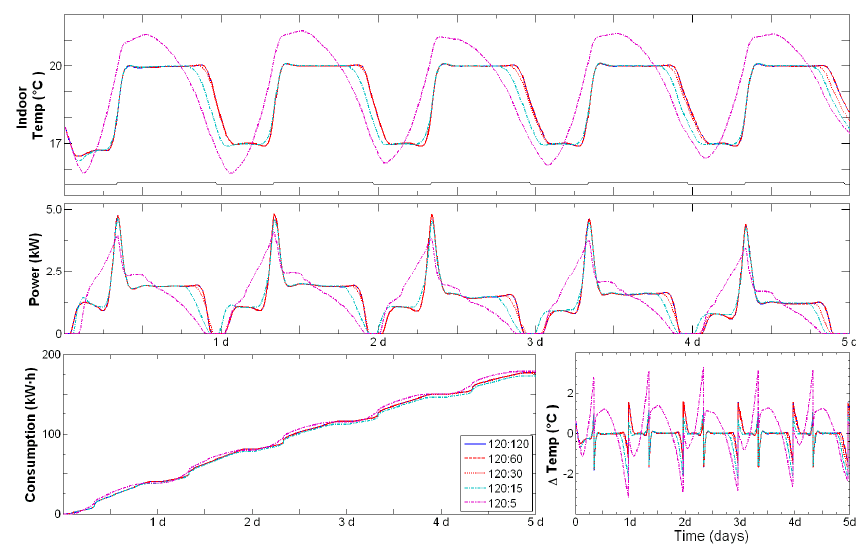
Figure 8. Variation of the control horizon respect a fixed prediction horizon (prediction:control). Black Line represents the variations of the temperature of reference.